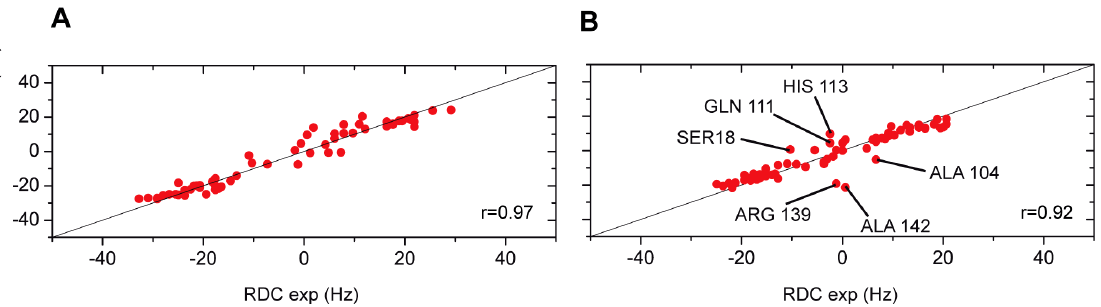
Figure 6. Experimental versus back-calculated RDC on the free protein structure. (A) Comparison of the experimental RDC measured for the free protein and the calculated RDC using the free protein structure 1R2D. (B) Comparison of the experimental RDC measured in the presence of fragment 1 and the back-calculated RDC using the free protein structure 1R2D. Residues exhibiting D RDC exp -RDC calc D w 6.5 Hz are labelled.